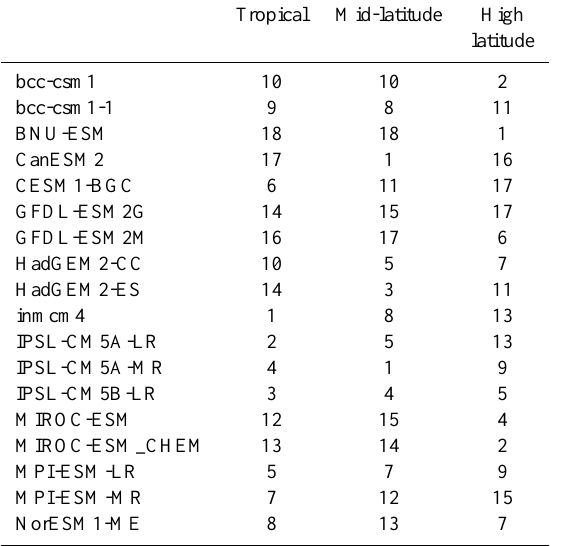
Table 3. Model ranking based on performance on mean annual and seasonal cycle metrics for each region (see description in Sect.